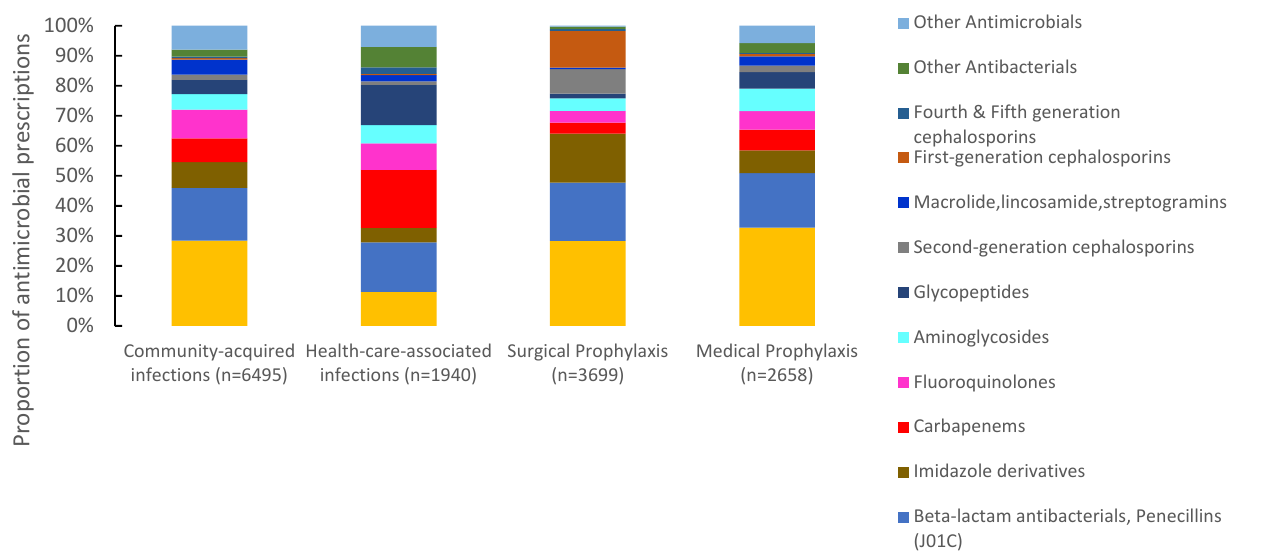
Figure 2. Indications of prescribed antimicrobials in 139 hospitals in seven countries in the Eastern Mediterranean Region, 2019 (n = 16,885). n = number of prescriptions.